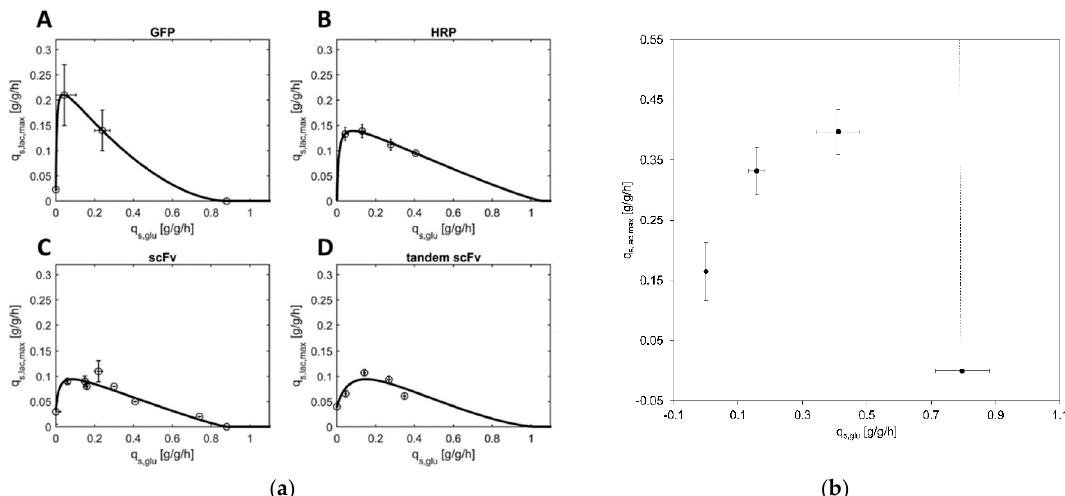
Figure 1. q s,glu /q s,lac,max -correlations ( a ) q s,glu /q s,lac,max -correlation for recombinant pET-based E. coli BL21 (DE3) strains producing either (A) GFP, (B) HRP, (C) the scFv or (D) the tandem scFv. Data-points were obtained from batch and fed-batch cultivations with constant q s,glu and excess lactose (“static experiments”) and subsequently fitted to the mechanistic model (Equation (1)) reprinted from [23] as a comparison to previously recorded correlations between q s,glu and q s,lac,max for plasmid-containing BL21 (DE3) strains. ( b ) q s,lac,max as a function of q s,glu for the GI strain; the data-points were gained from the different batch and fed-batch cultivations: Point 1 (q s,lac,max 0.17 ± 0.05 g/g/h at q s,glu 0 g/g/h) is derived from a fed-batch only on lactose, the two middle points (q s,lac,max 0.33 ± 0.05 g/g/h at q s,glu 0.19 ± 0.04 g/g/h; q s,lac,max 0.40 ± 0.04 g/g/h at q s,glu 0.41 ± 0.07 g/g/h) were calculated from fed-batch cultivations where limiting amounts of glucose were fed and lactose was provided in excess, and point 4 (on the right) indicates the value of the maximum specific glucose uptake rate. Above this point, also indicated by a dotted line, glucose would accumulate and therefore no lactose uptake would occur due to the well-known phenomenon of diauxic growth and carbon catabolite repression whenever glucose and lactose are present in excess e.g., [29–31]. The error bars indicate the standard deviation of q s,glu and q s,lac,max during the cultivations.